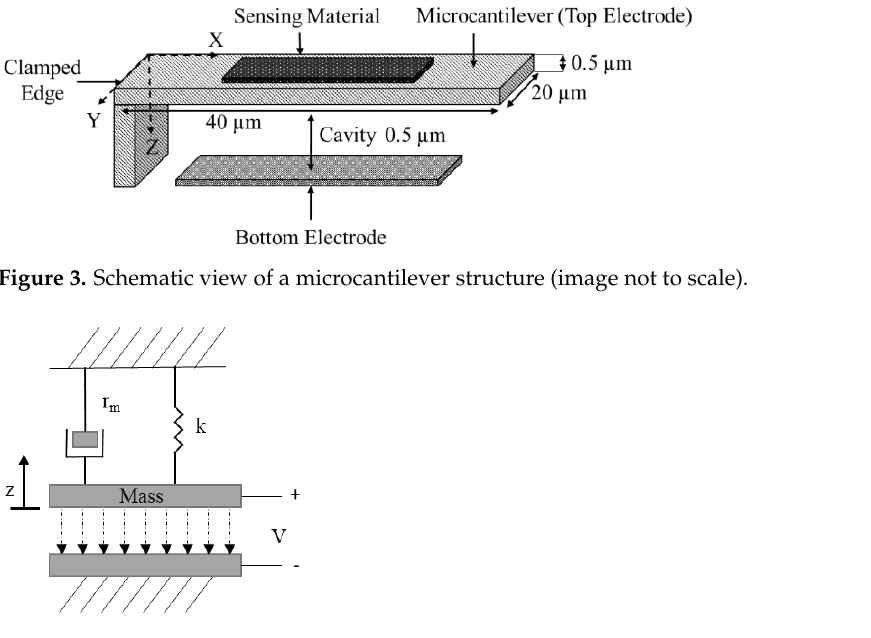
Figure 4. Mechanical model for microcantilever, microbridge, and capacitive clamped membrane.